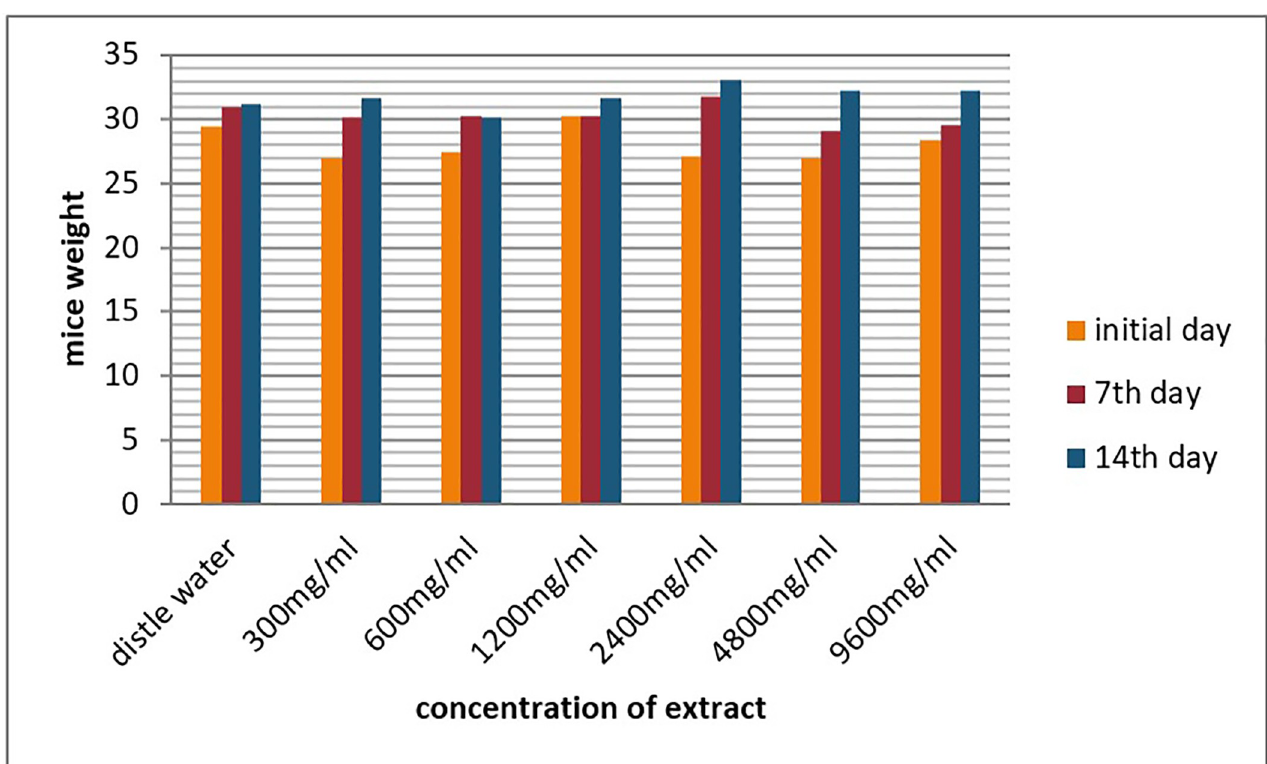
Fig 2. The effect of the aqueous extract of I. tinctoria A. Rich roots on the bodyweight of mice on different days.